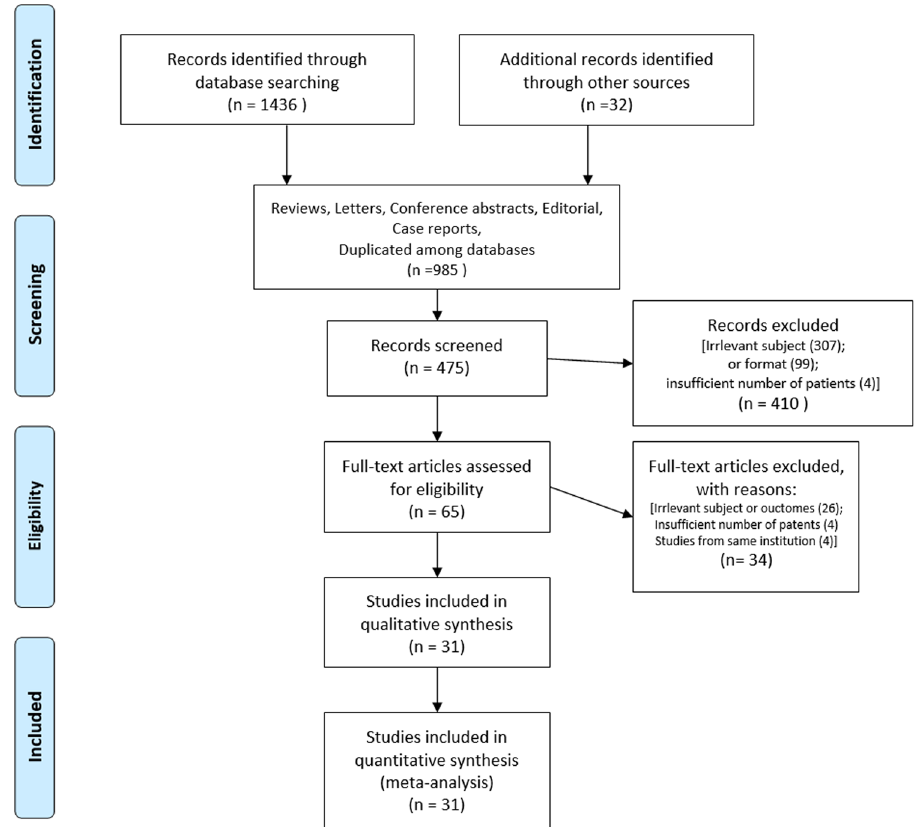
Fig. 1 Study selection process: among the 1468 records intially searched, 31 studies were included in the current patients with prostate cancer, three included patients with color- ectal cancer, two included patients with esophageal cancer, two included patients with hepatocellular carcinoma (HCC), and one each included patients with the bile duct, head and neck, sarcoma, and multiple cancers. Most studies (25, 81%) included patients with synchronous and/or metachronous oligometastases and six (19%)